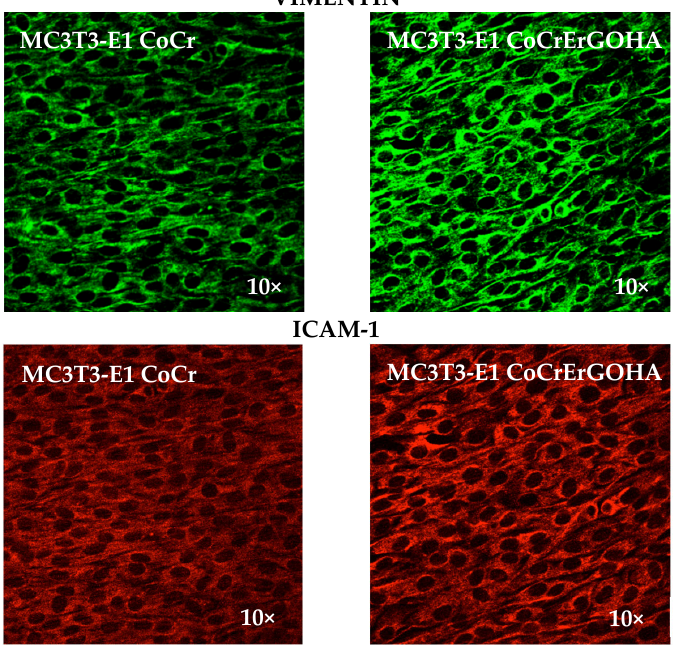
Figure 8. Vimentin detection analyzed by immunofluorescence ( top ) and ICAM ‐ 1 ( bottom ) fluorescence in MC3T3 ‐ E1 osteoblast cell cultures exposed to CoCrErGOHA and CoCr.